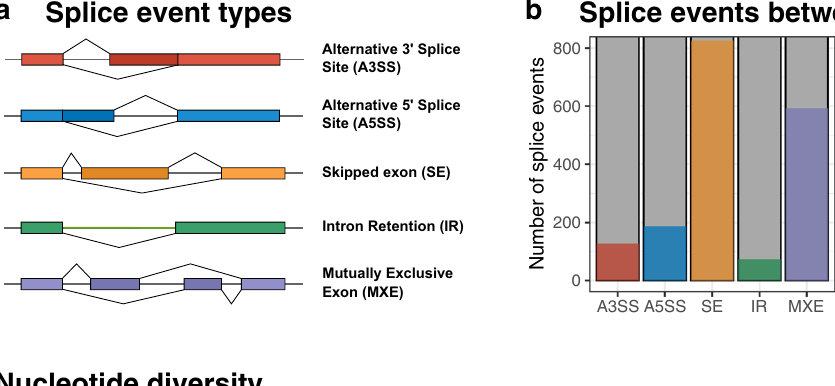
Supplementary Data 5) and the subset of events that were signi fi cantly differentially spliced between seasonal morphs (Fig. 4b; Supplementary Fig. 10b, zoom panels). In both the abdomen and thorax, skipped exons (SE) and mutually exclusive exons (MXE) were most abundant, while IR events were least abundant. Between 6.5% and 17.5% of detected events were differentially spliced. There were more differentially spliced SE events than expected, whereas the remaining splice types had